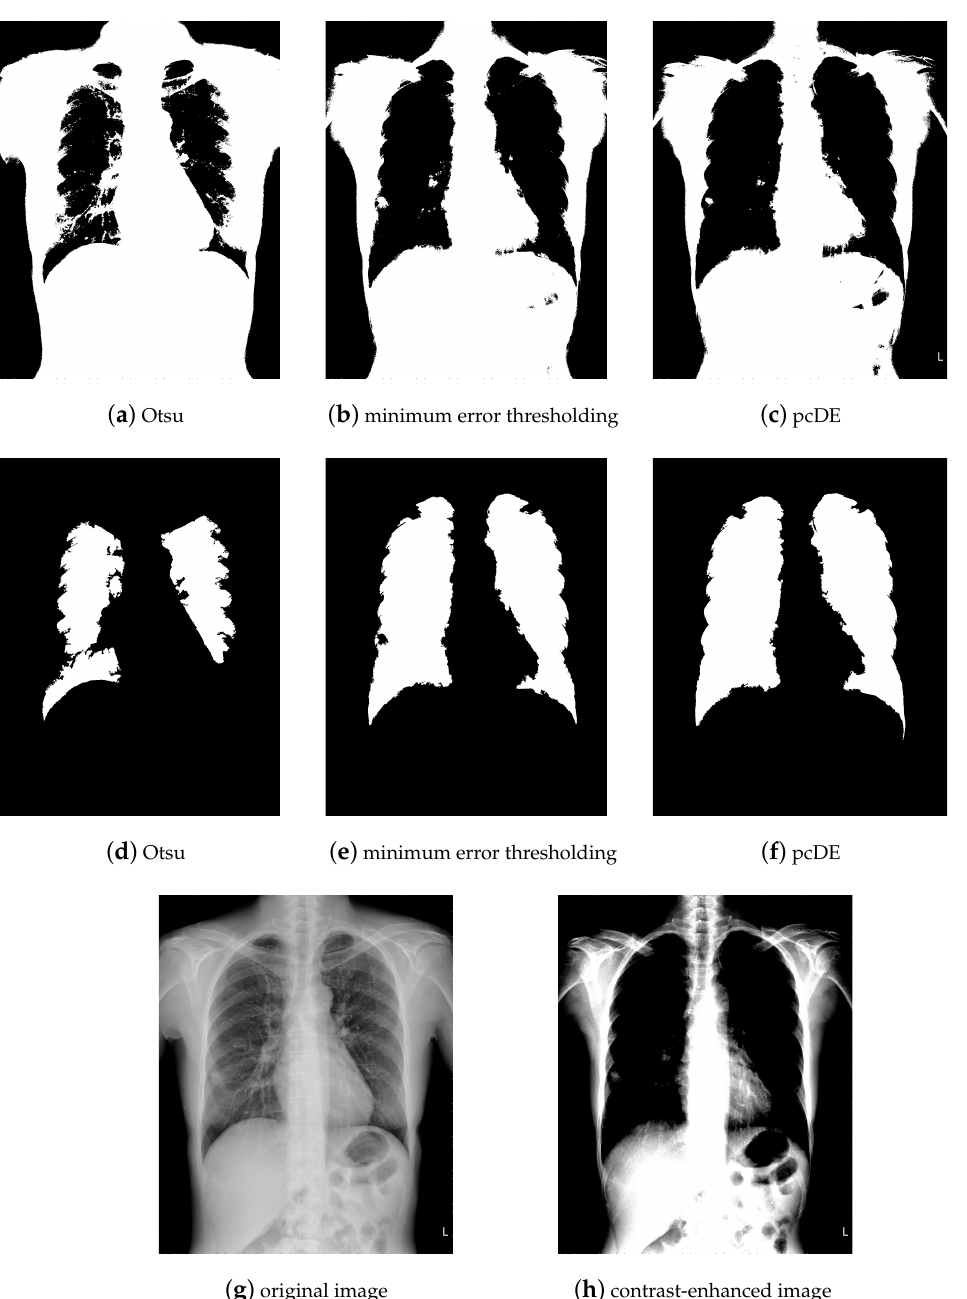
Figure 9. ( a – c ) image after threshold segmentation, ( d – f ) image after morphological processing, ( g ) original image, ( h ) contrast-enhanced